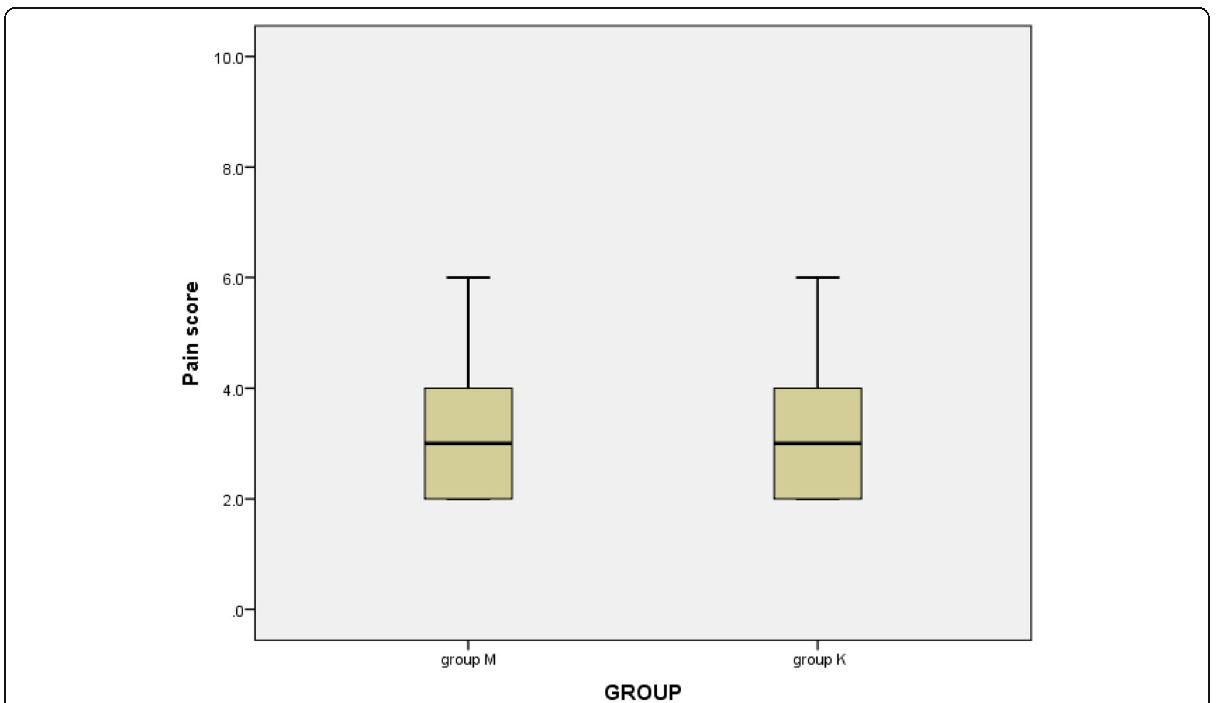
Fig. 5 Comparing both groups as regards postoperative pain score. The middle black solid line signifies the median, the upper and lower margins of each box are the IQR, and the whiskers are the maximum